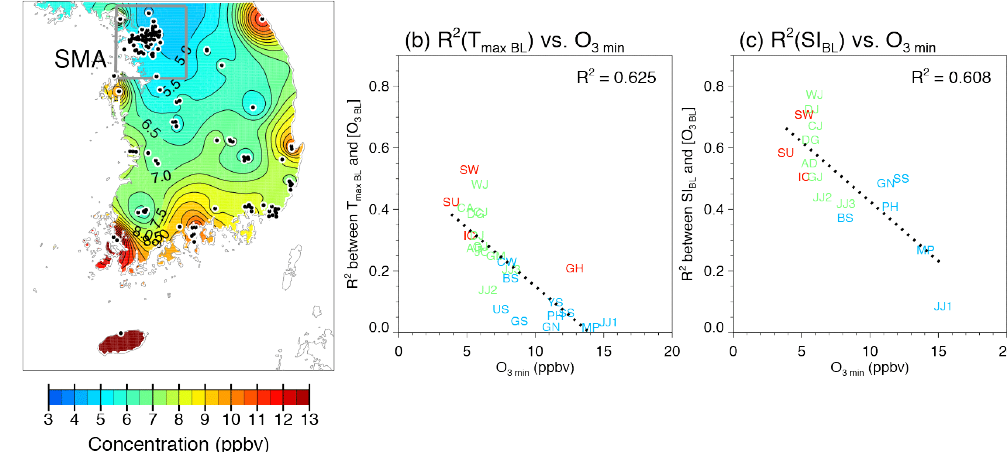
Figure 6. (a) Spatial distribution of 12yr averaged concentrations of O 3min for the period 1999–2010 using data from 124 air quality monitoring sites (black dots) of NIER. (b) Scatter plot of R 2 between [O 3BL ] and T maxBL vs. O 3min at 25 cities. (c) Scatter plot of R 2 between [O 3BL ] and SI BL vs. O 3min at 17 cities. City codes in red, green, and blue indicate the SMA, inland, and coastal cities,